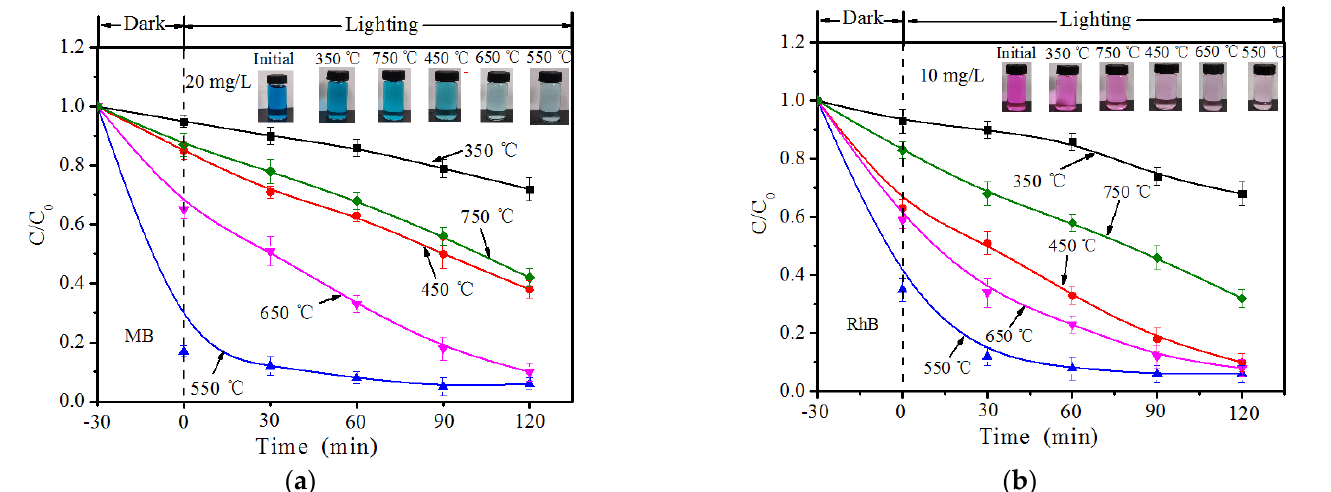
Figure 3. The adsorption–photocatalytic degradation curves of MB ( a ) and RhB ( b ) over B-TiO 2 /C 3 N 4 .